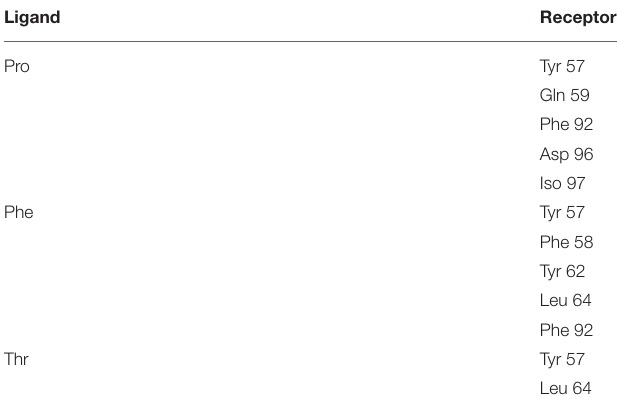
TABLE 2 | Binding residues implicated on β -casein and B. cereus P2 interaction.